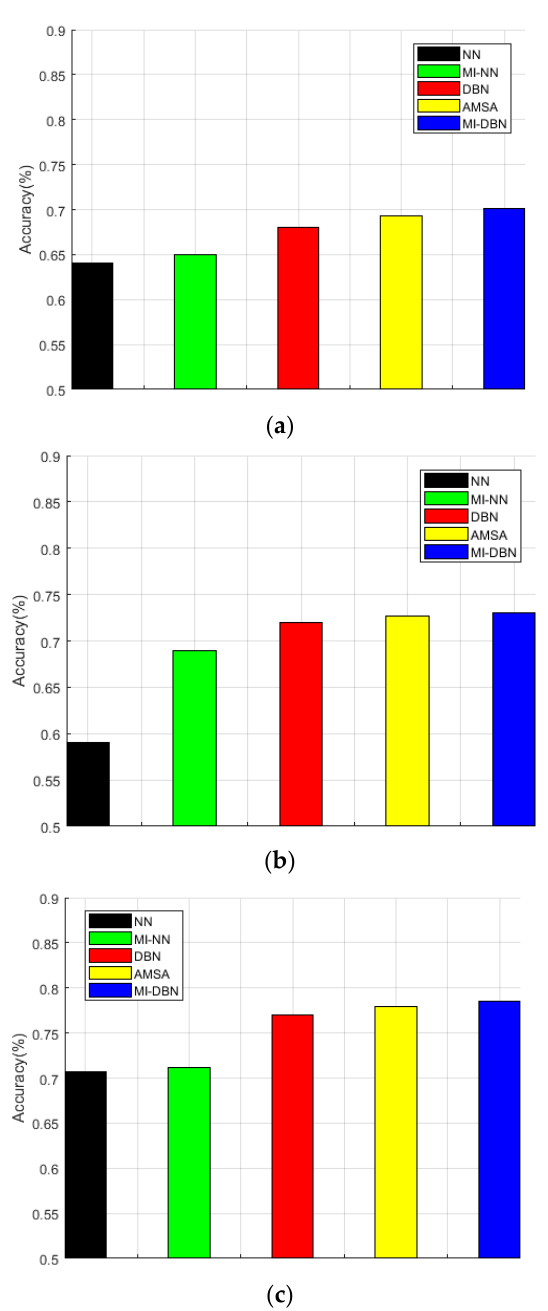
Figure 3. The tests of NN, MI-NN, DBN, AMSA, and MI-DBN with Poker Hand. The accuracies are plotted on the horizontal axis. ( a ) α = 10%; ( b ) α = 30%; ( c ) α =